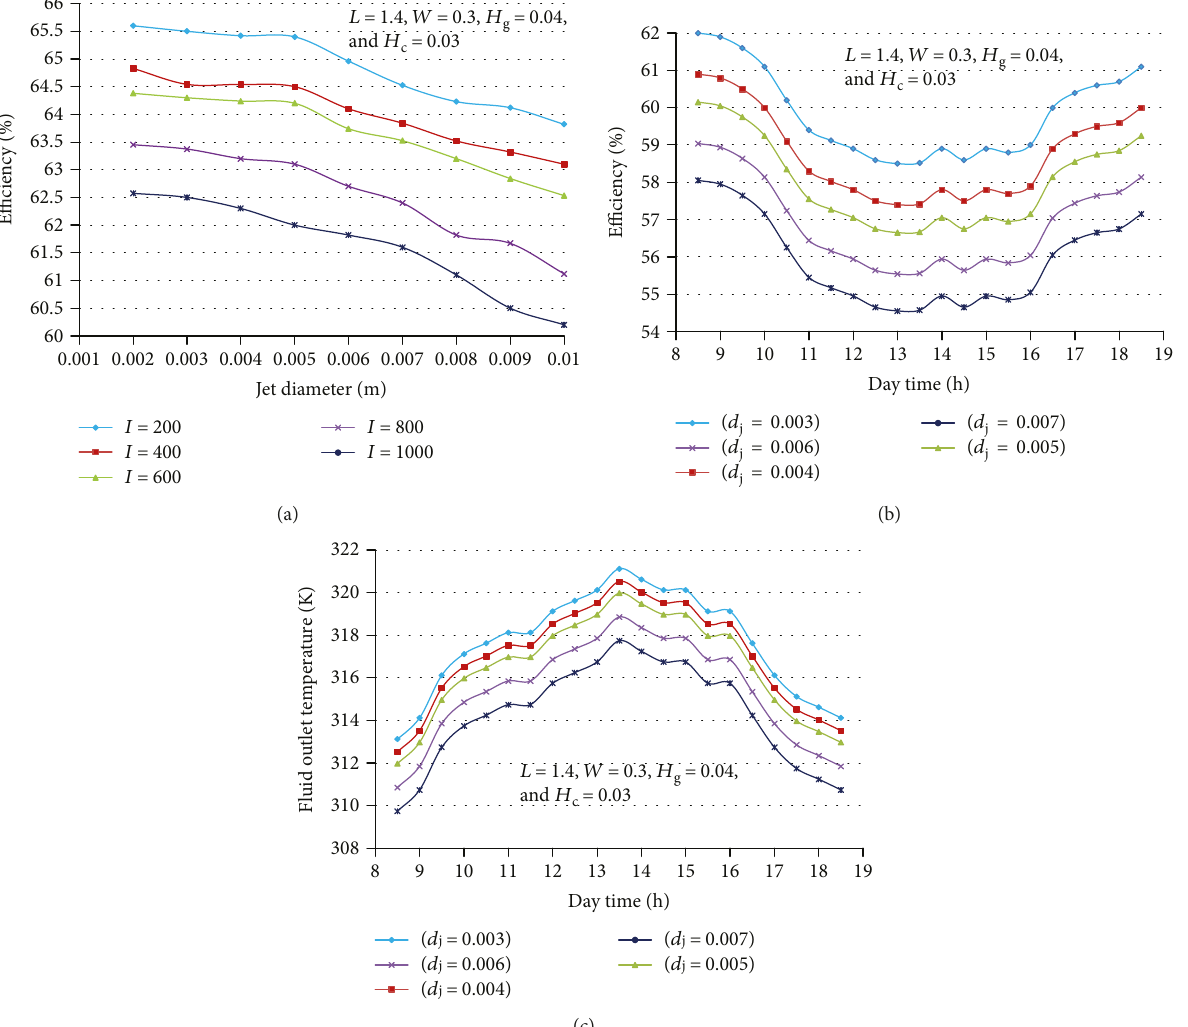
Figure 21: Prediction of the optimum jet diameter ( d ) of the proposed solar air heater. (a) SAH e ffi ciency versus jet diameter at j di ff erent solar radiation levels. (b) Hourly SAH e ffi ciency over daytime at di ff erent jet diameters. (c) Hourly air outlet temperature at di ff erent jet